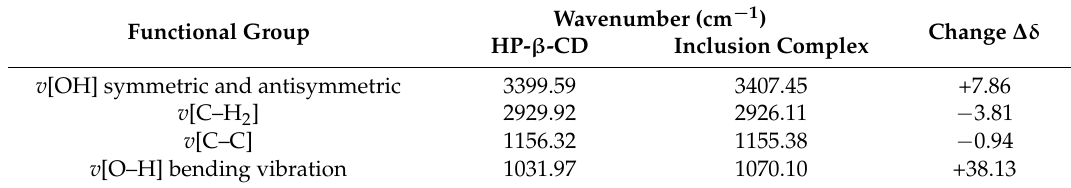
Figure 3. ( a ) The chemical structure of aniracetam ( b ) FTIR spectra of aniracetam, HP- β -CD, physical mixture, and inclusion complex (1:1). Scan range of 500–4000 cm − 1 , resolution of 2 cm − 1 , with 128 scans per sample. Table 2. Comparison between the FTIR spectra intensity of HP- β -CD and the inclusion complex.